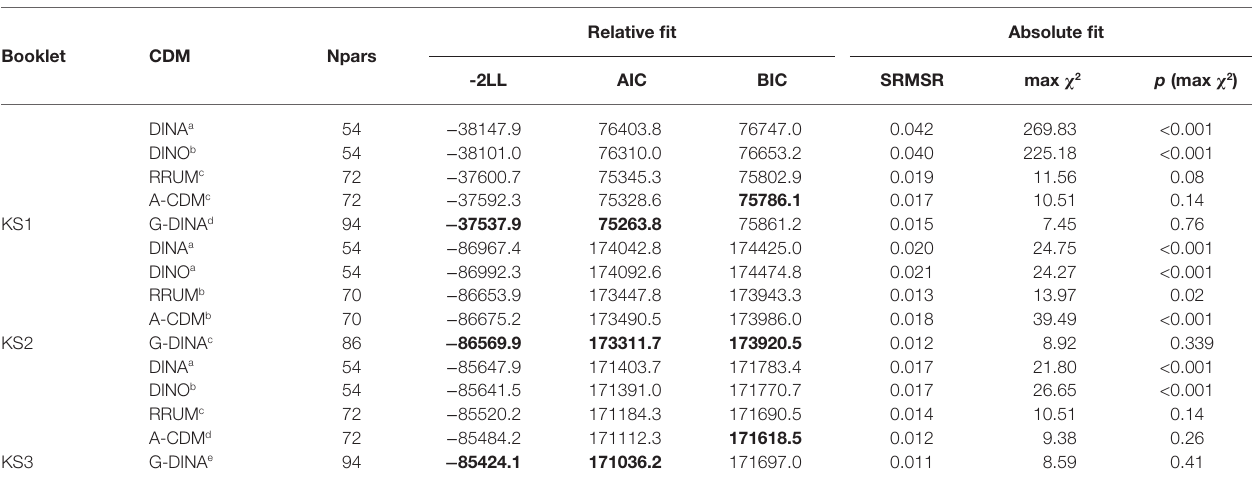
TABLE 5 | Model fit comparison of CDMs using the final